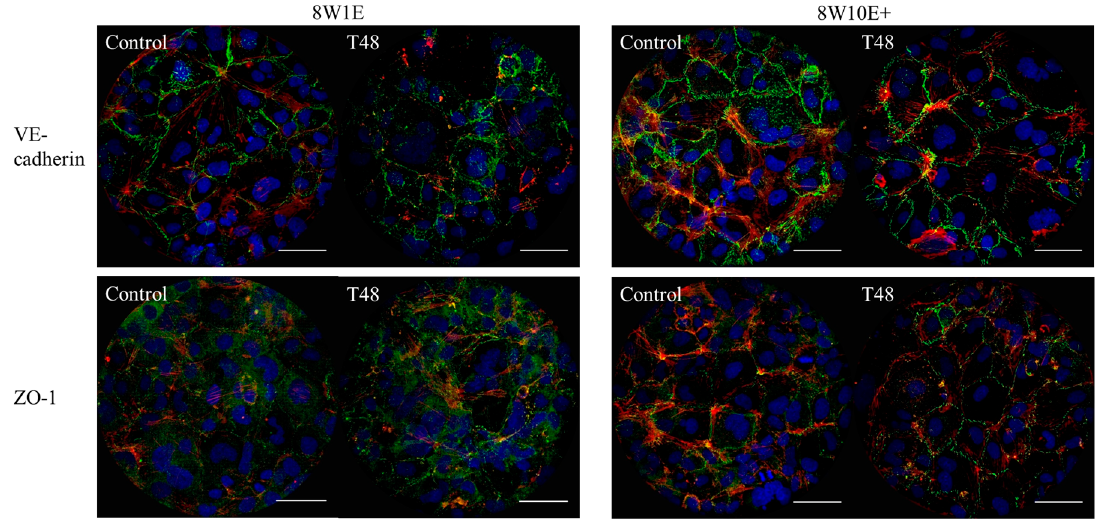
Figure 5. Changes in the hCMVEC morphology after wounding on the 8W10E+ and 8W1E arrays using the ECIS-Z Ɵ system. Expression of the adherens junction protein, VE-cadherin, and the tight junction regulating protein, ZO-1, under control and wounded conditions in the hCMVECs on the 8W1E and 8W10E+ arrays. Representative images of three independent experiments are shown; images are a Z-stack composition between 0.4–0.8 µm at 48 h post-wounding and the control cells. The hCMVECs are labelled for VE-cadherin using mouse monoclonal CD144 antibody, ZO-1 using mouse monoclonal ZO-1 antibody, visualized by goat α -mouse Alexa Fluor 488 (green) at 40× magnification on the LSM 710 inverted confocal microscope. Actin filaments are stained with ActinRed 555 ReadyProbes Reagent (red). Nuclei are counterstained with Hoechst (blue). The hCMVECs were seeded at a density of 60,000 cells/cm 2 . A wounding current of 3000 uA at 60 kHz was delivered for 30 s to selected wells on the 8W1E array, and a wounding current of 5000 uA at 60 kHz was delivered for 60 s to selected wells on the 8W10E+ array. Scale bar = 50 µ